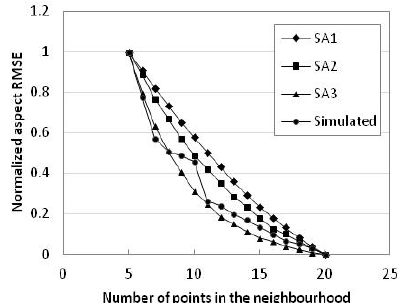
Figure 9. Plot of the slope RMSE with number of points in the neighbourhood in study areas 1–3 and simulated data.